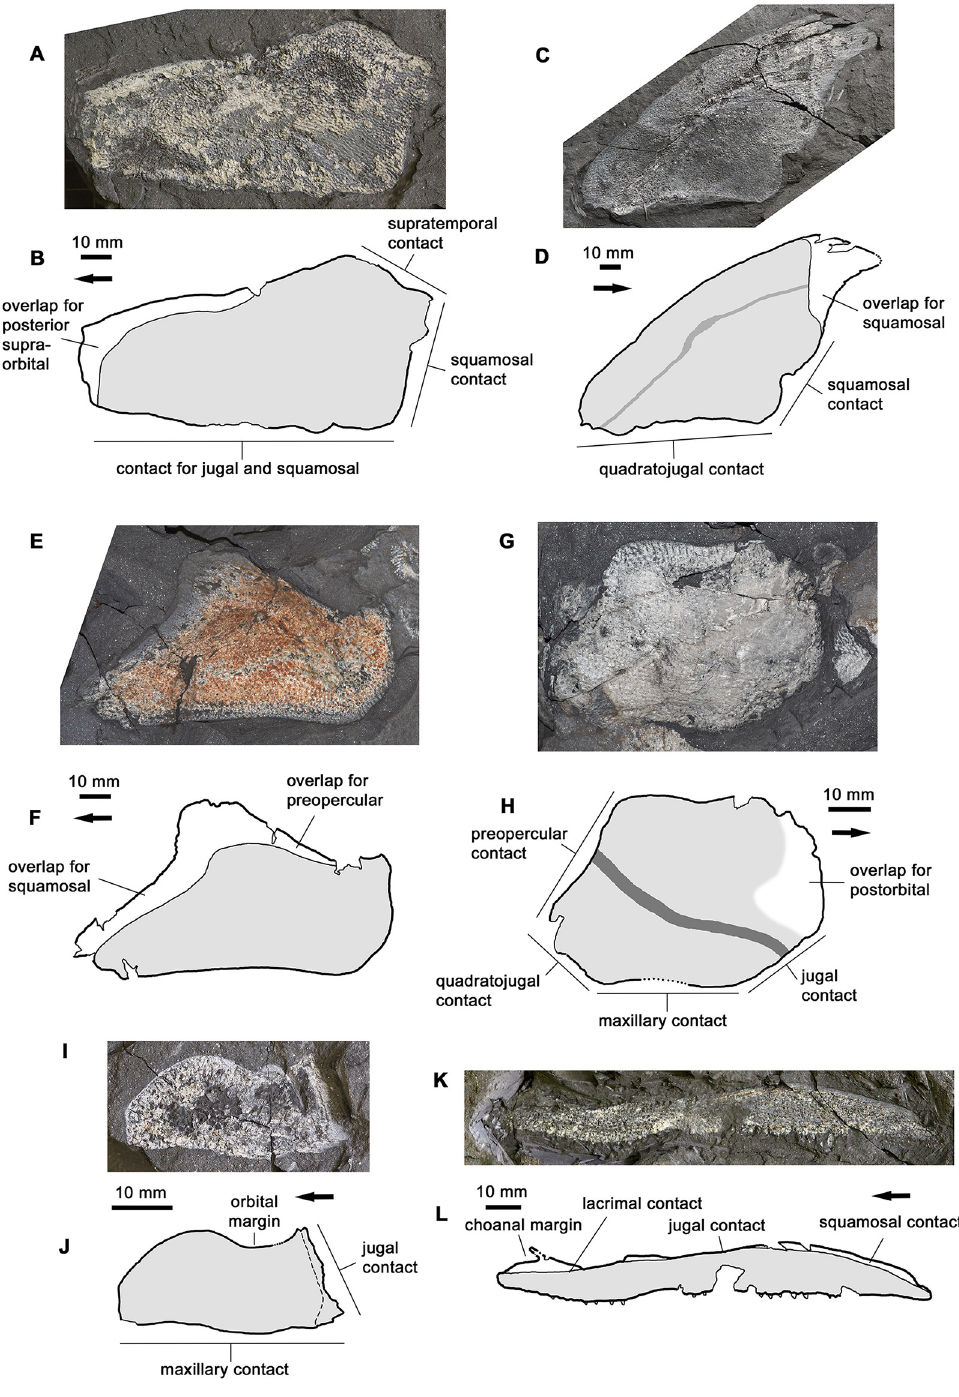
Fig 5. Cheek bones. A-B, photo and interpretative drawing of postorbital AM6541b. C-D, photo and interpretative drawing of preopercular AM6535b. E-F, photo and interpretative drawing of quadratojugal AM6528b. G-H, photo and interpretative drawing of squamosal AM18001. I-J, photo and interpretative drawing of lacrimal AM6526b. K-L, photo and interpretative drawing of maxilla AM6503a. Graphic conventions as in Fig 4. In H, the edge of the postorbital overlap is indistinct and is shown as a blurred